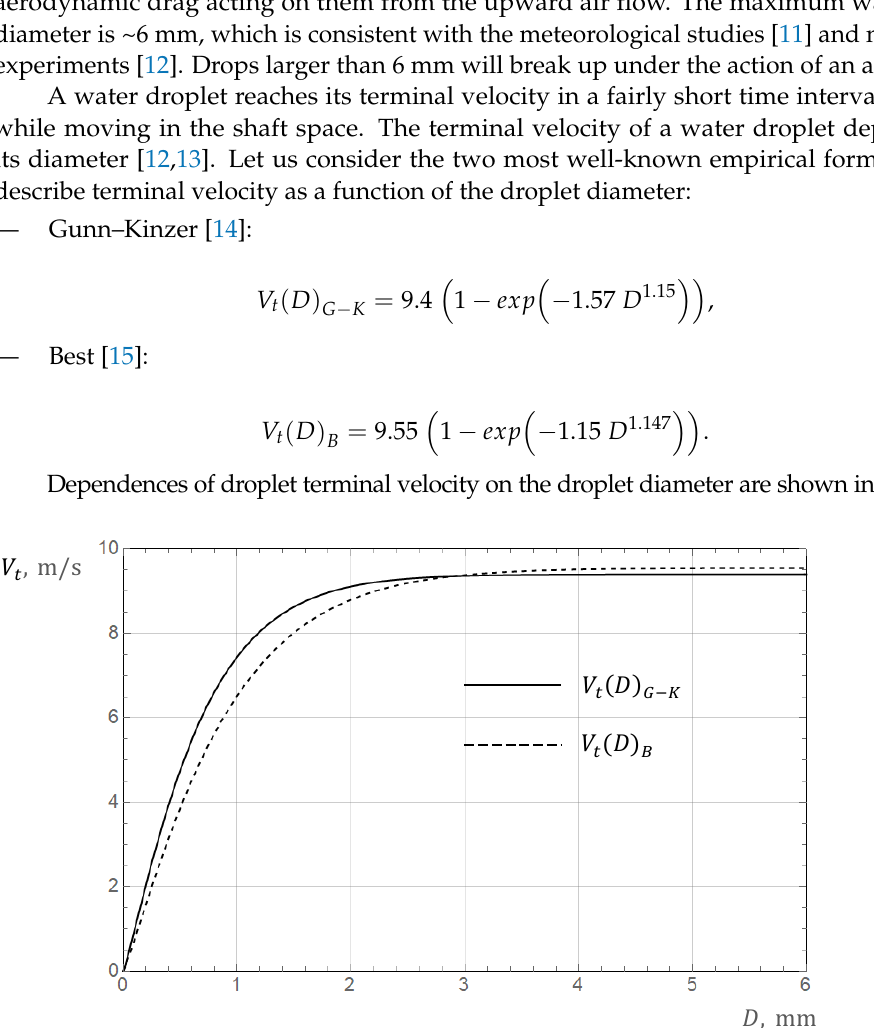
Figure 1. Droplet terminal velocity, depending on the droplet diameter.